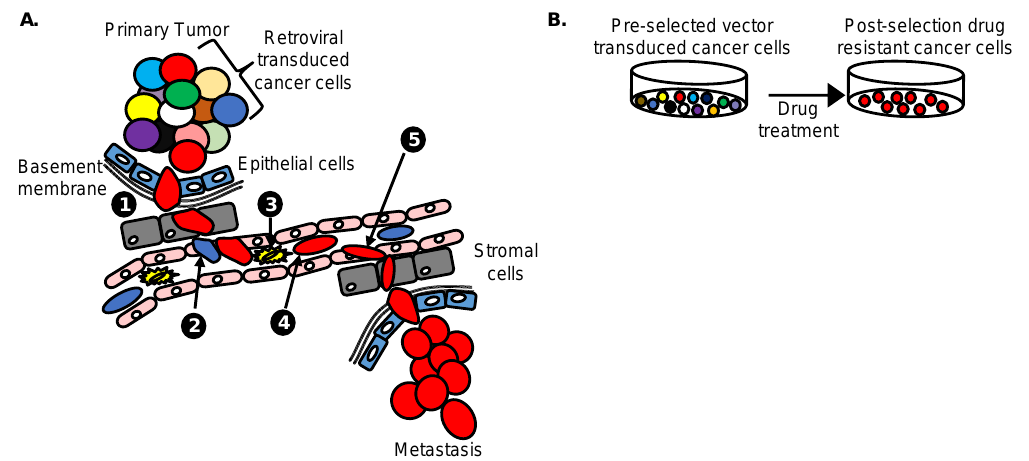
Figure 4. Retroviral insertional mutagenesis screens. ( A ) Approach to identify cancer metastasis driver genes in vivo. Retroviral vector transduced cancer cells are tagged and indicated as different colors. Cells with a selective advantage to (1) invade underlying basement membrane (2) intravasate (3) withstand circulatory pressure and (4) migrate (5) extravasate and metastasize to distal organs (Red) can be identified; ( B ) Approach to identify cancer drug resistance genes in vitro. Treated cancer cells are transduced with retroviral vector leading to a polyclonal population of cells with RIS that are randomly distributed in the genome. Following increased drug dosing, the cells with RIS near genes that confer a selective advantage to survive and grow will be enriched (Red). Analysis of RIS on the red cells identifies candidate cancer drug resistant driver genes that promote drug resistance in cells.